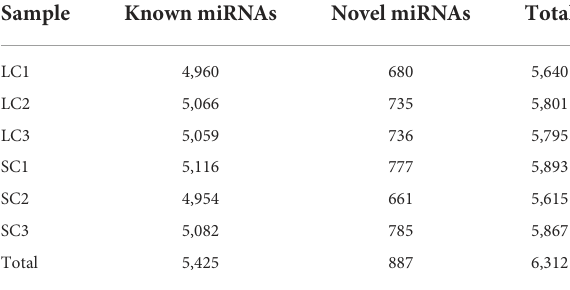
TABLE 3 Statistical results of